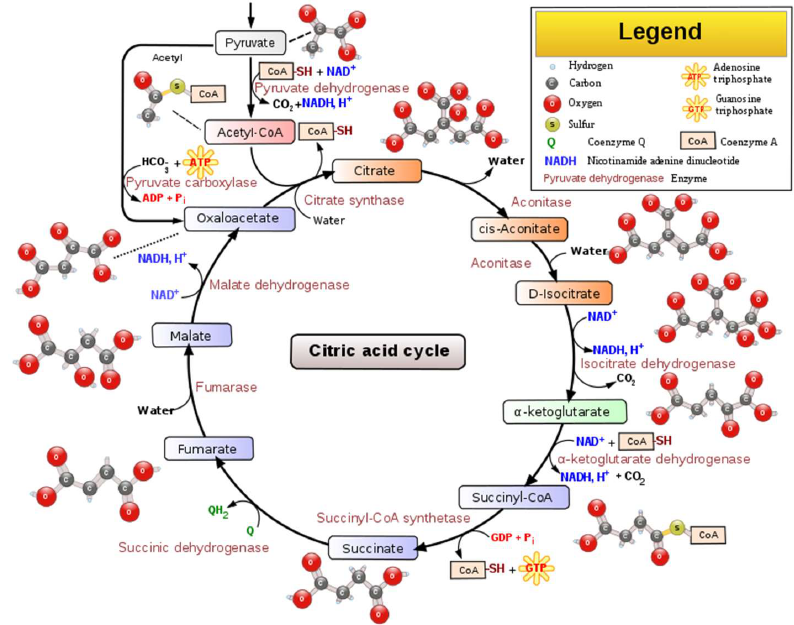
Figure 2. Schematic representation of the main steps, intermediated compounds, and enzymes of the TCA cycle [10].